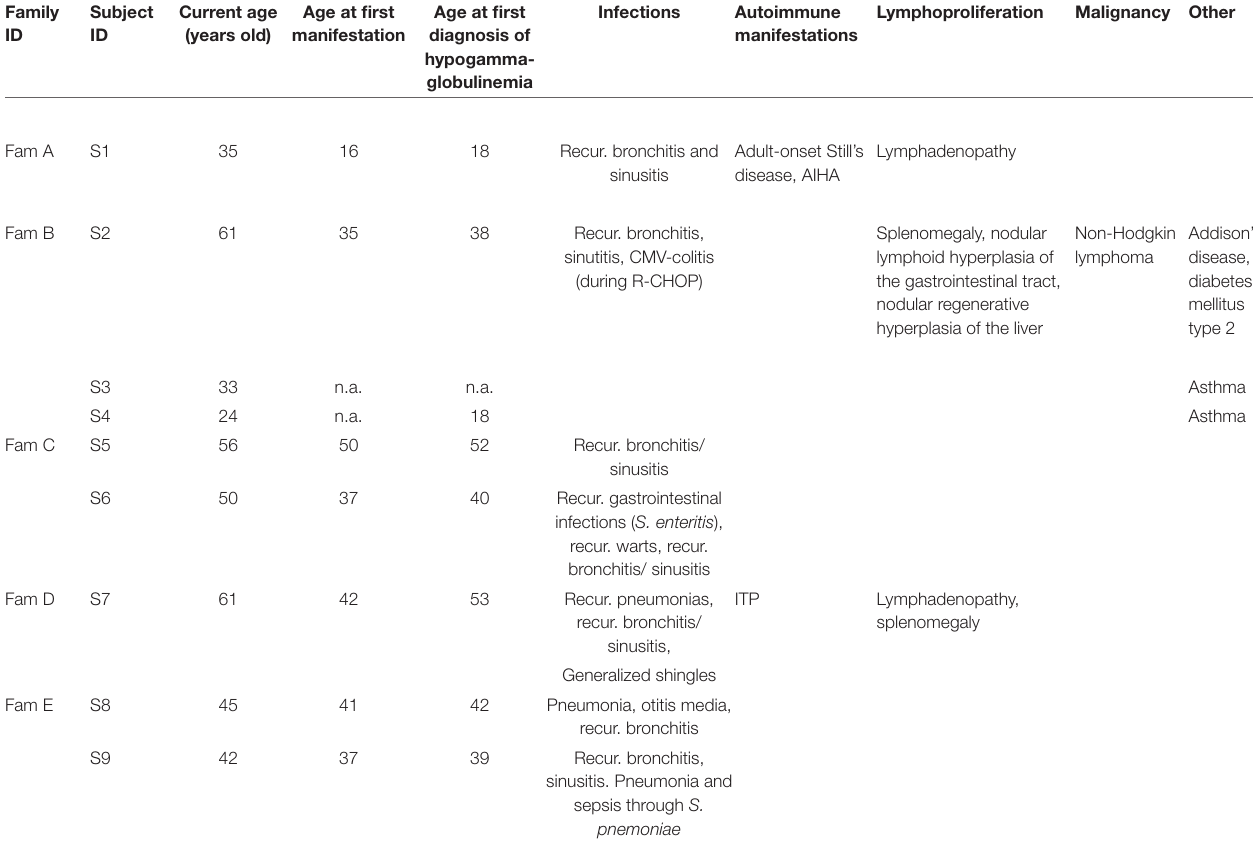
TABLE 1 | Clinical characteristics of subjects with NFKB1 mutations. Family